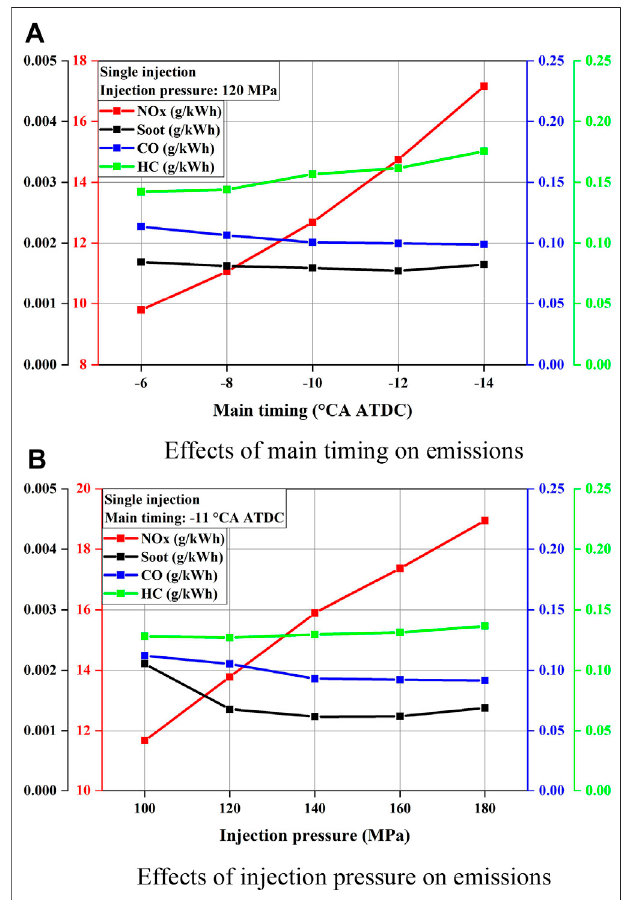
FIGURE 4 | Effects of single main injection timing and pressure on emissions. (A) Effects of main timing on emissions. (B) Effects of injection pressure on